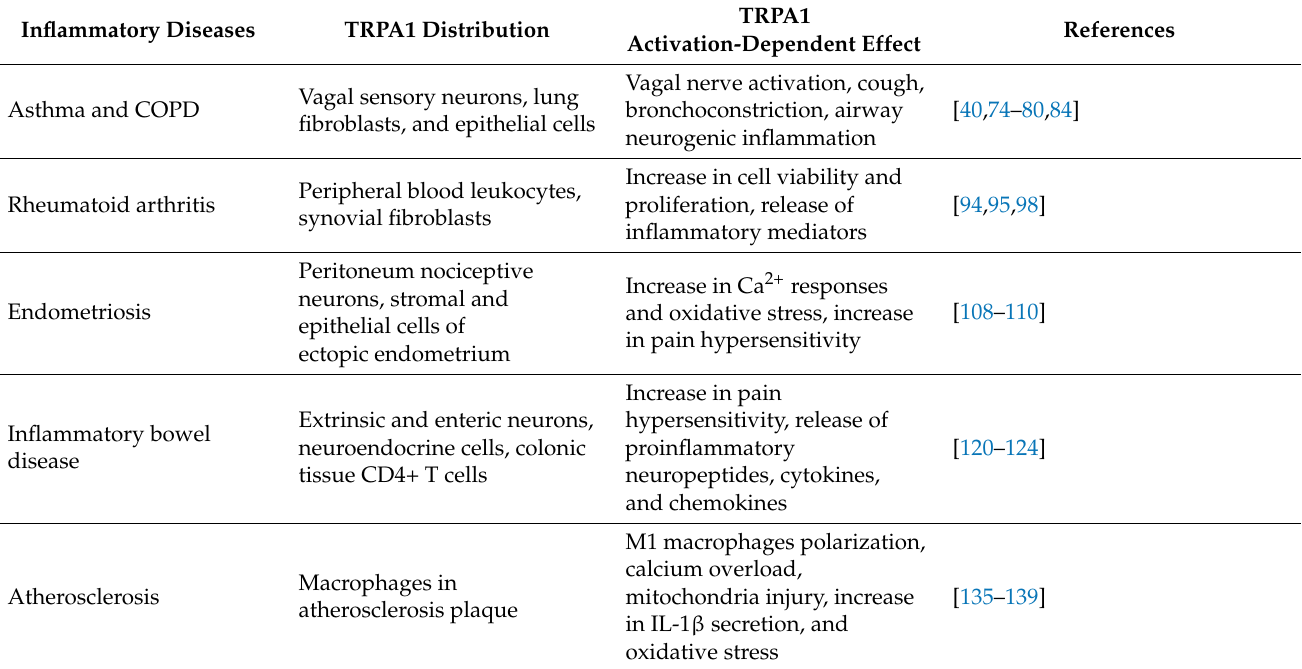
Table 1. TRPA1 in inflammatory